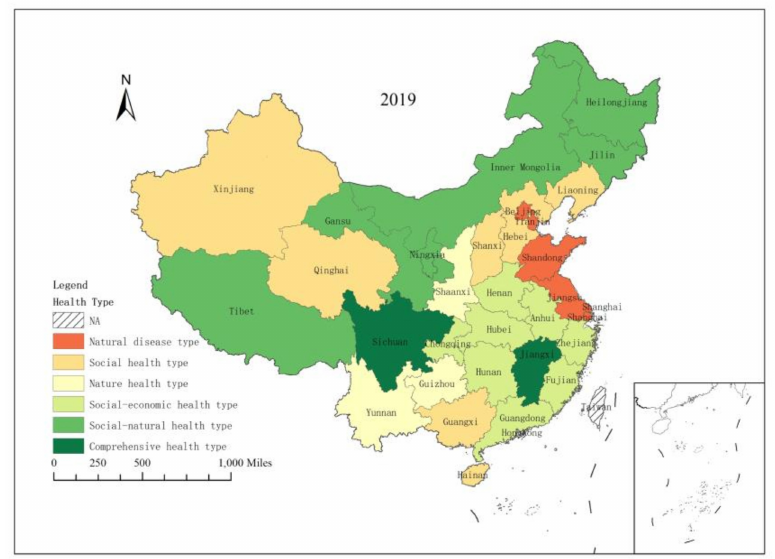
Figure 5. Spatial distribution of ecosystem health classifications in 30 provinces,